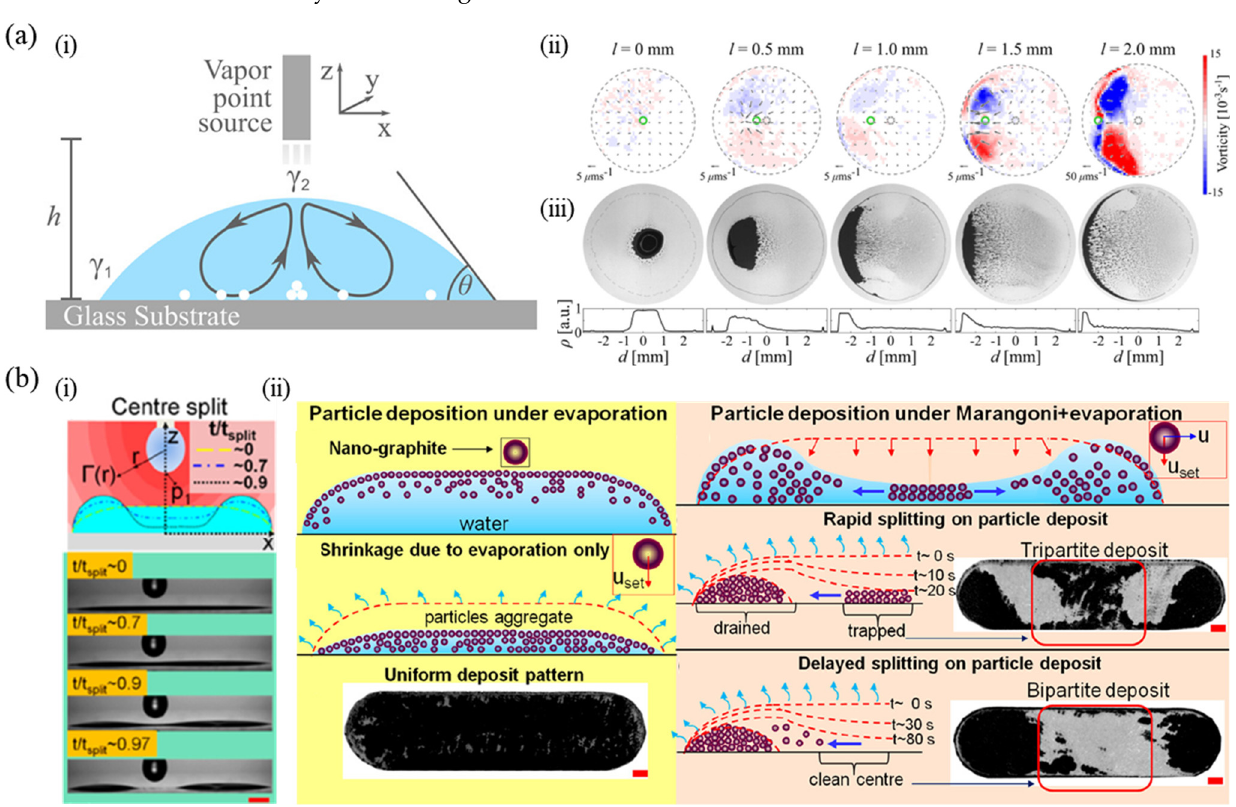
Figure 4. ( a ) (i) Schematic representation of an evaporating sessile droplet under a vapor point source. (ii) Velocity vectors and vorticity by the Marangoni flows as a function of the lateral displacement 𝑙 of the vapor point source from the droplet’s center for ℎ = 2 mm. (iii) Final deposits after evaporation of sessile drops. The bottom histograms show the corresponding deposit’s density profile along the droplet’s diameter and the densities were averaged along the angular coordinate (reproduced with permission from ref. [102]. Copyright 2018 American Chemical Society). ( b ) (i) Center split of a long sessile drop by an evaporating ethanol droplet. The scale bar equals 1 mm. (ii) Particle deposition under only evaporation and the combined Marangoni flow and evaporation showing Moses’s effect. Scale bars are 1 mm (reproduced with permission from ref. [103]. Copyright 2020 American Chemical